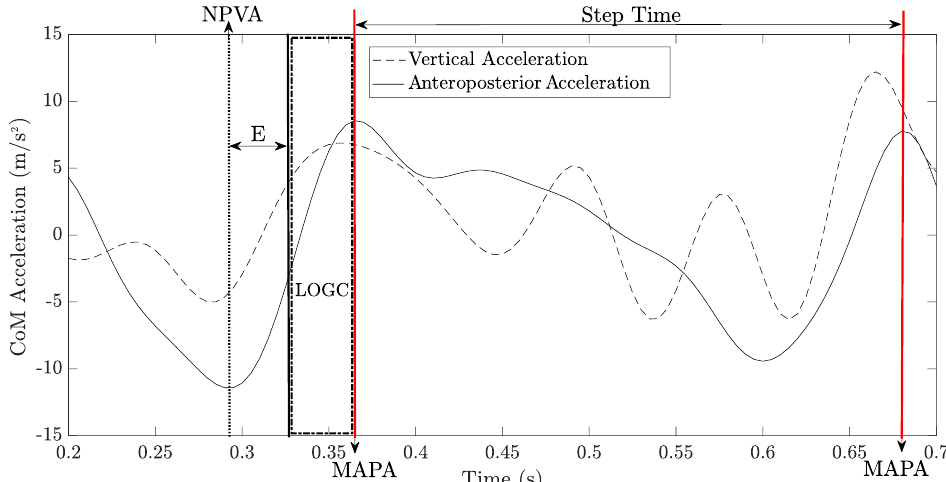
Figure 3. The correlation between the approximated CoM accelerations and temporal events (NPVA: temporal instant of negative peak vertical acceleration; MAPA: temporal instant of maximum anteroposterior acceleration). The temporal distance E is the threshold value for loss of ground contact (LOGC) assessment. The temporal distance between two following MAPA represents the step time. Notice that, differently from Equation 1, we have used the following nomenclature; NPVA = t min MAPA = t max i + 1